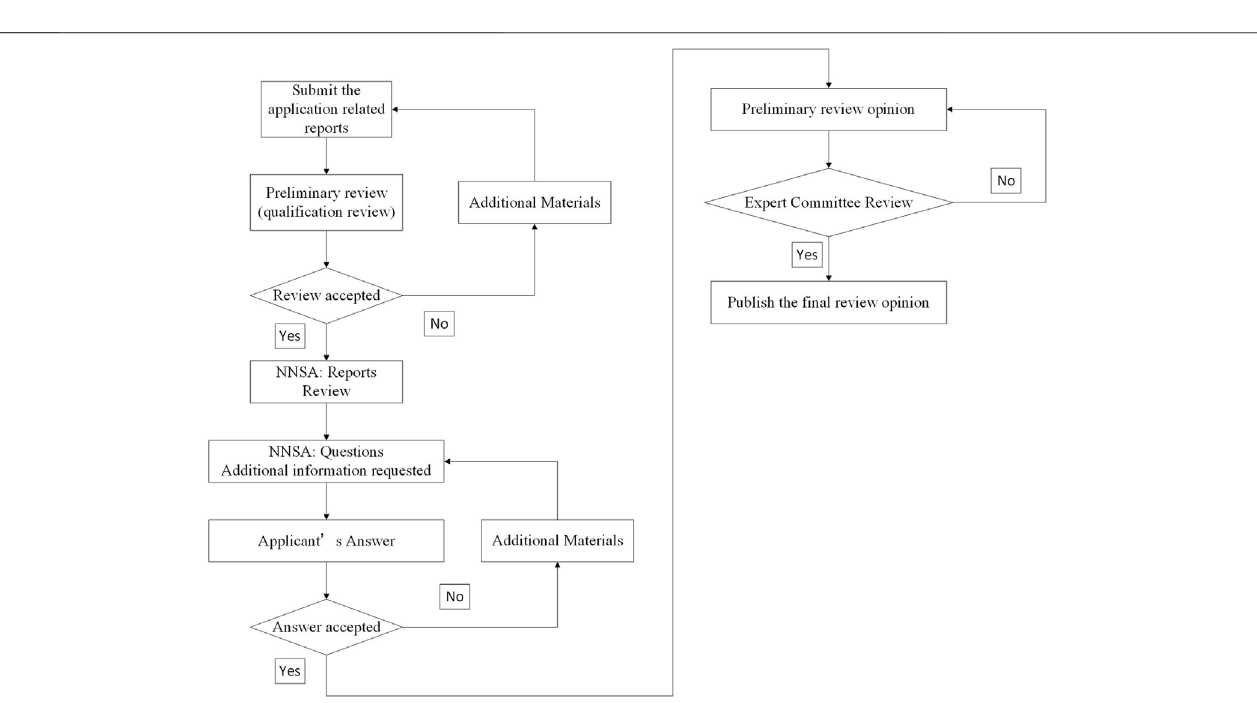
FIGURE 1 | Software safety evaluation work fl ow